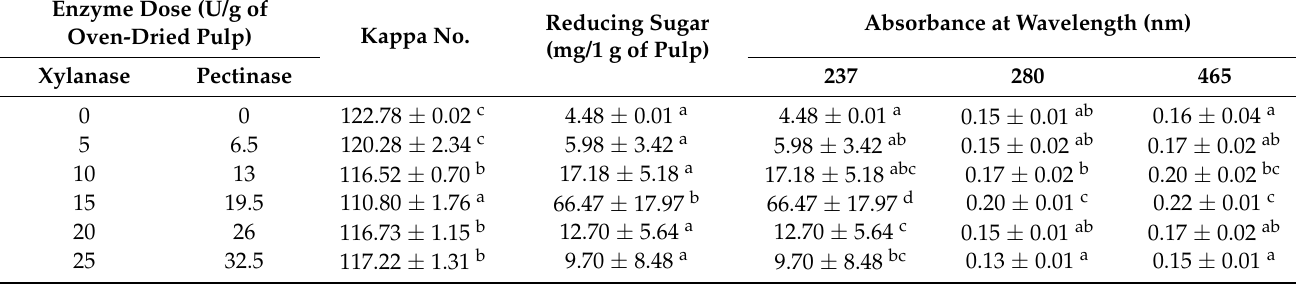
Table 1. Effect of varying enzyme doses on pulp biobleaching.